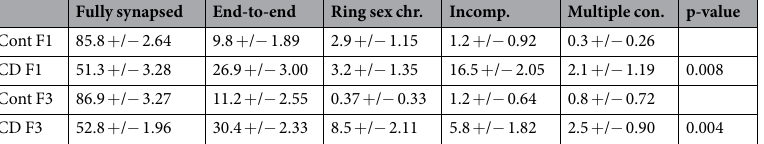
Table 1. A quantitative analysis of meiotic synapsing defects. The classification in the table denotes fully synapsed chromosomes, telomere end-to-end connections, ring chromosomes (X and Y chromosomes form a ring), incomplete synapsing (one or two chromosomes have un-synapsed part), and multiple connections (several chromosomes are connected) (F1, p -value = 0.008, n = 5 control, n = 5 CD; F3, p -value = 0.004, n = 4 control, n = 4 CD, Pearson’s Chi-squared